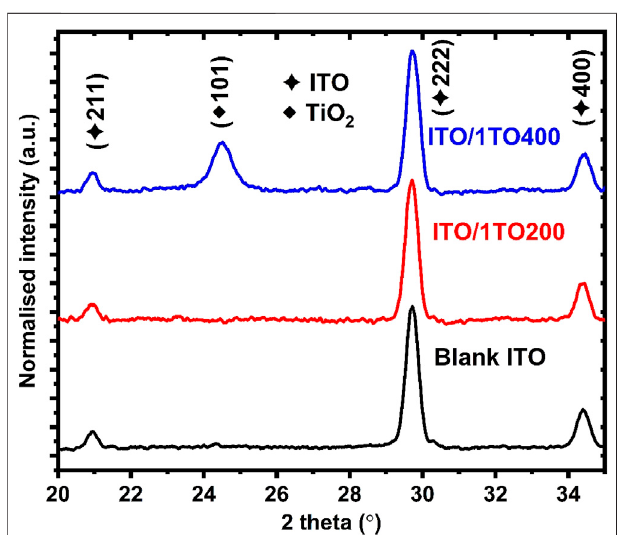
FIGURE 7 | XRD analysis results of the annealed TiO 2 coatings and the uncoated